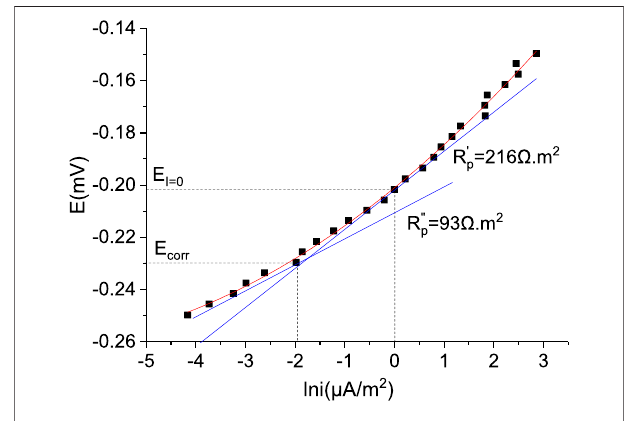
FIGURE 9 | Polarization curves of feature points.